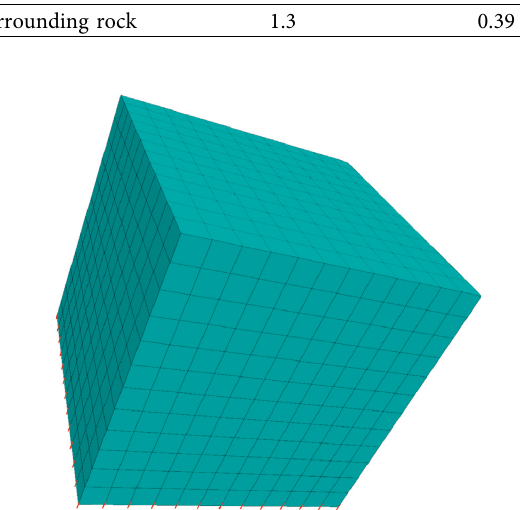
Figure 6: Variation law for ultimate strain of equivalent rock block under different loads.